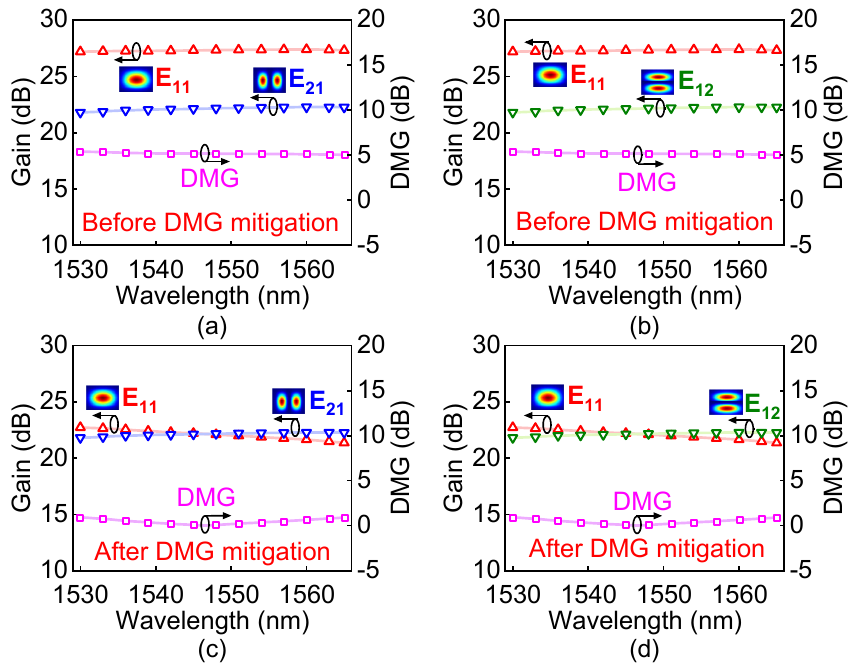
Figure 14. The variations of the gains and DMGs versus wavelength over the C − band for three modes: ( a , b ) before DMG mitigation and ( c , d ) after DMG mitigation.